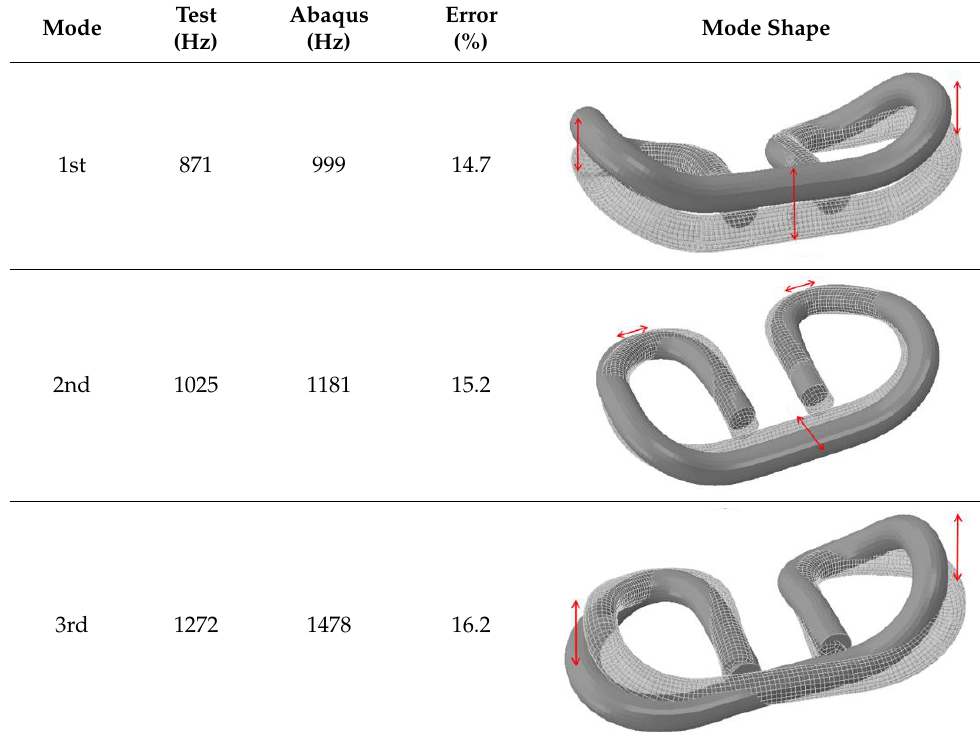
Figure 10. Comparison of test results and those obtained through Abaqus (maximum principal strains) in step 1: ( a ) left section; ( b ) center section; ( c ) right section; ( d ) strain gauge locations. Table 2. Comparison of natural frequencies (test vs. Abaqus).